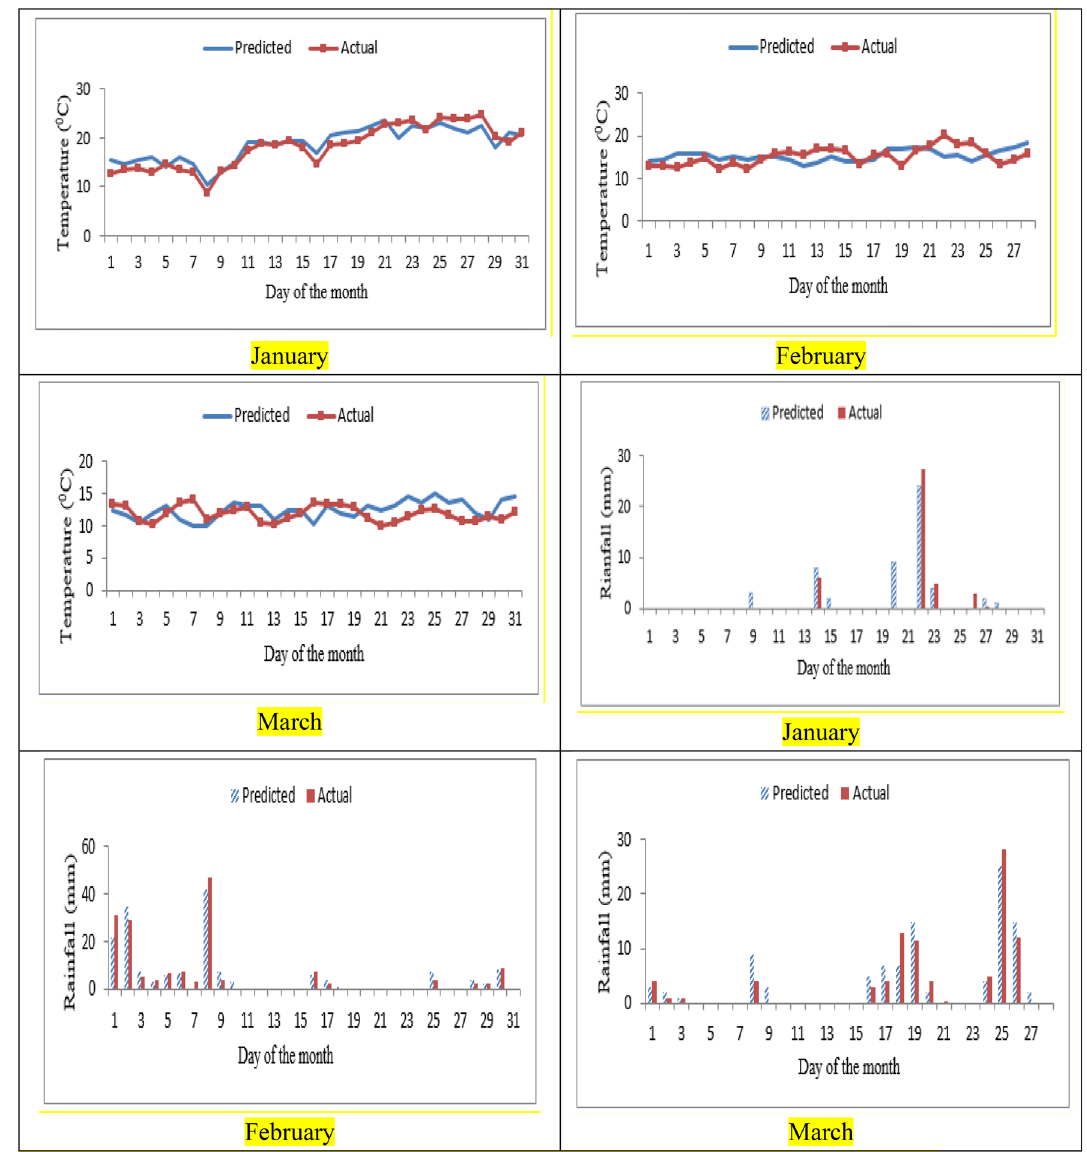
Fig. 8 Plot of actual and predicted temperature and rainfall comparison for Peshawar station. Data Source : Regional Meteorological